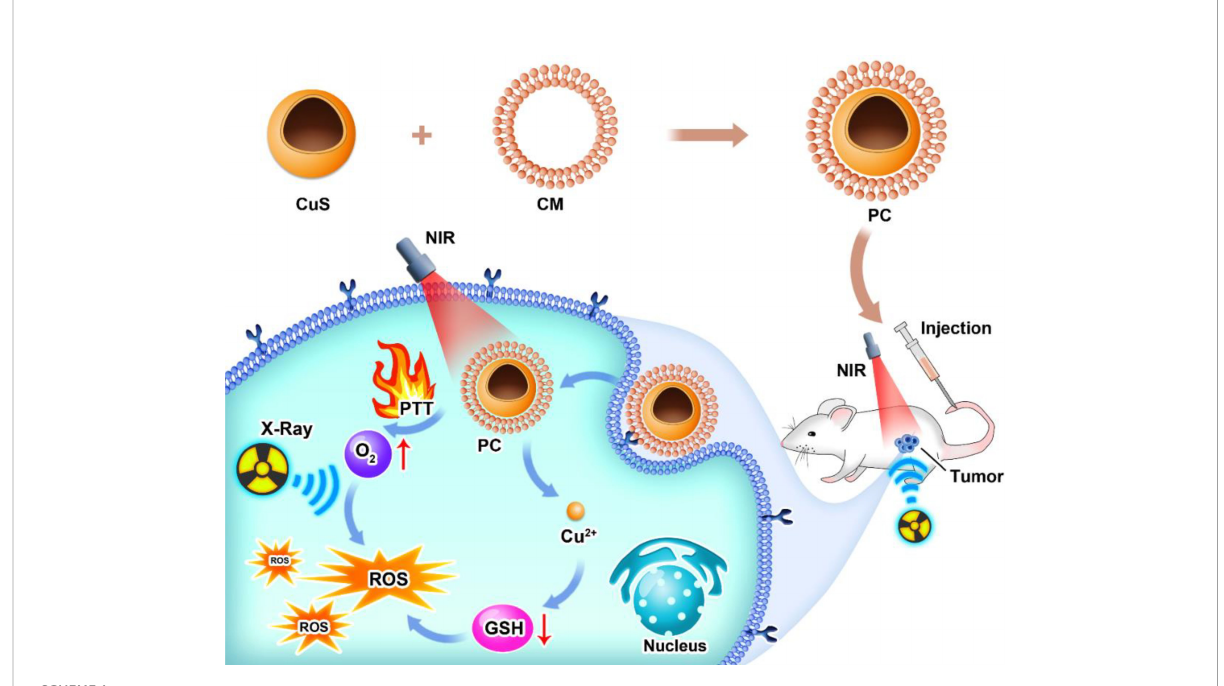
SCHEME 1 Illustration of PC preparation and cancer